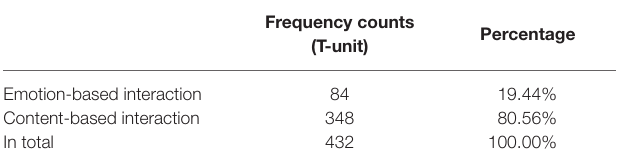
TABLE 4 | Frequency counts and percentages of emotion-based interaction and content-based